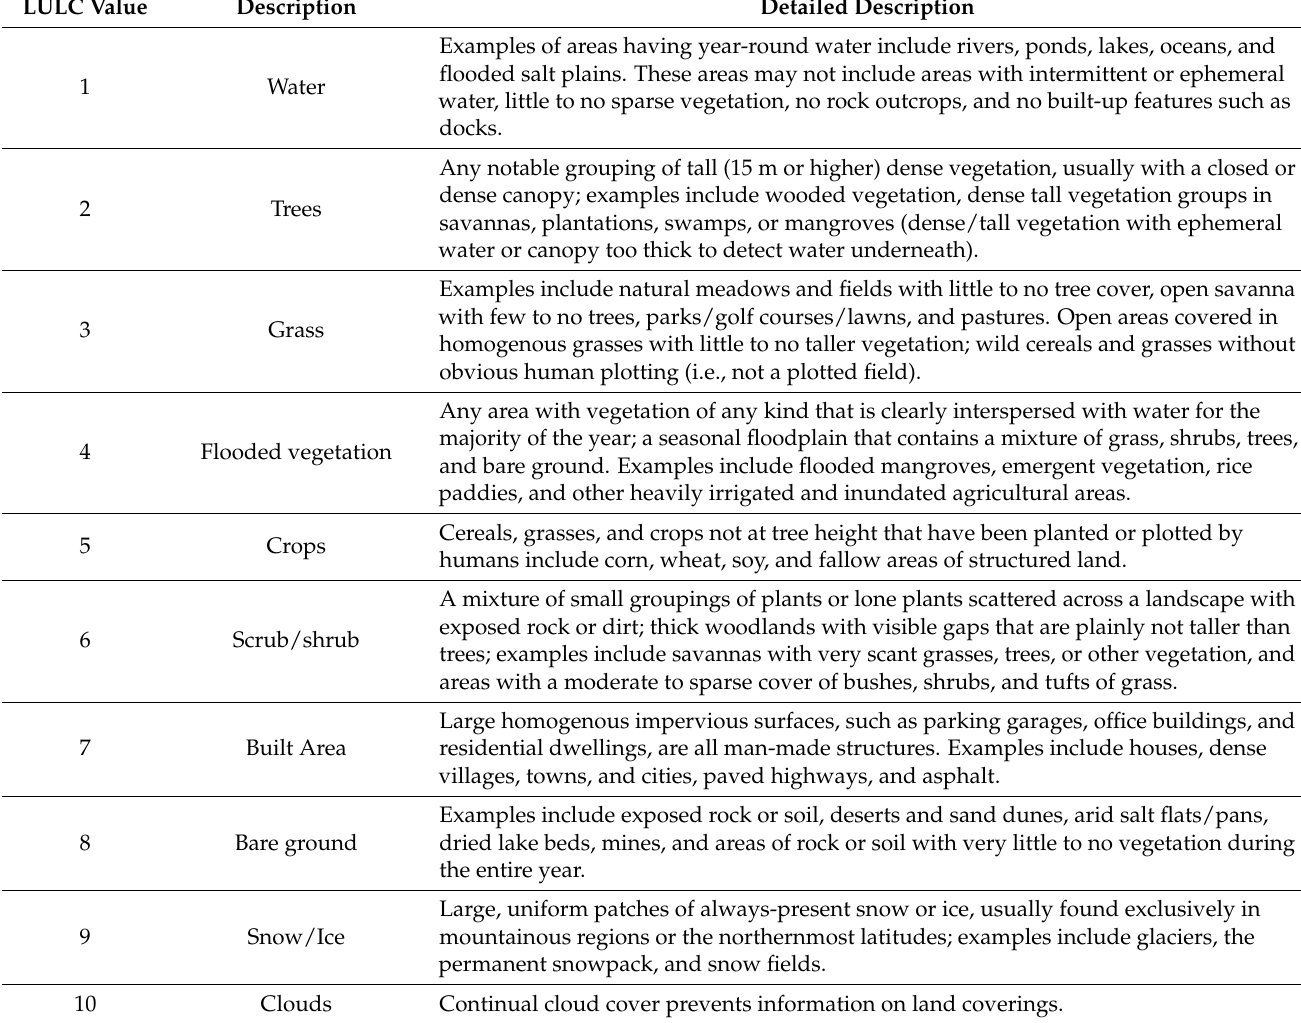
Table 2. LULC 2020-ESRI classifications and detailed topology descriptions